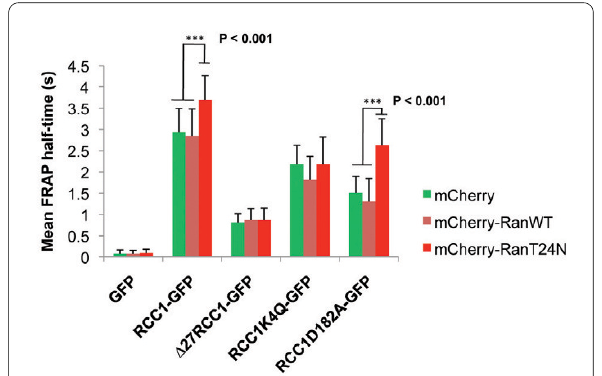
Figure 3 Stabilisation of the interaction of RCC1α with chromatin by Ran requires the methylated N-terminal tail of RCC1α . Bar chart showing the mean FRAP t 1/2 +/- SD of live U2OS cells co-expressing wild-type RCC1α-GFP, Δ27RCC1-GFP, RCC1α K4Q -GFP or RCC1α D182A - GFP with mCherry empty vector (green), mCherry-Ran WT (pink) or mCherry-Ran T24N (red). Data were tested for significant difference in FRAP t 1/2 using the Student's t -test. P-values considered to be statisti- cally different (< 0.001) are indicated as ***. cally stabilises the interaction of RCC1α with chromatin in live cells.